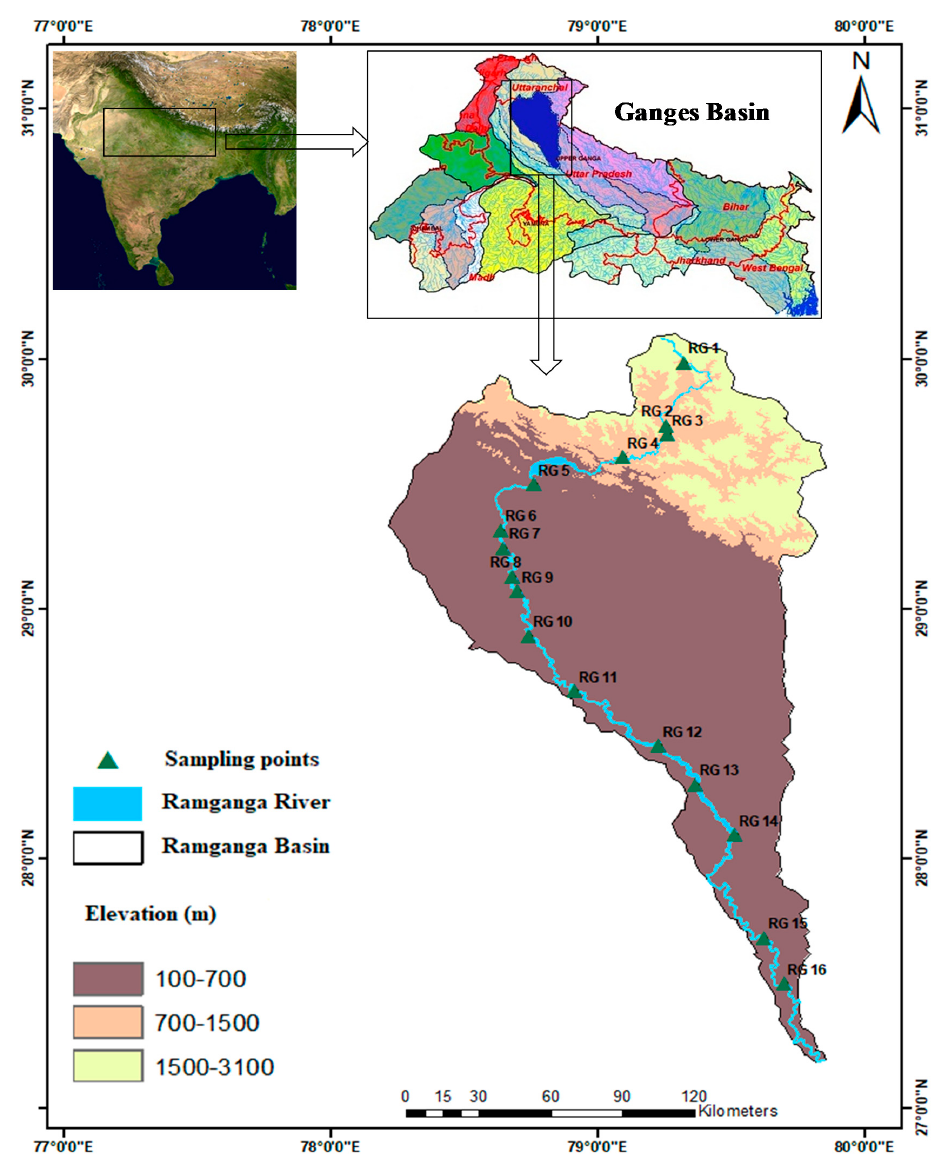
Figure 2. Map showing the Ramganga River and the locations of samples.